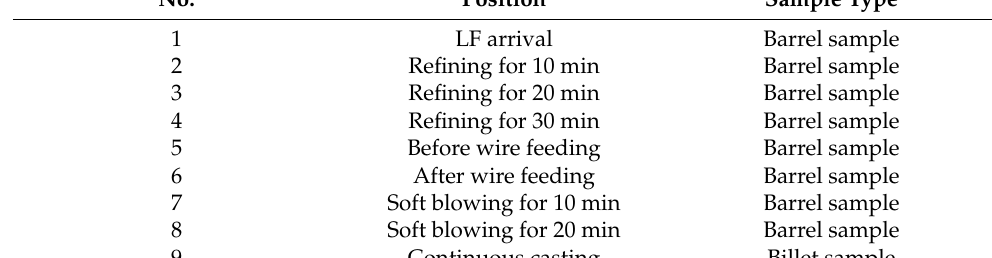
Table 4. Sampling position and sample type.